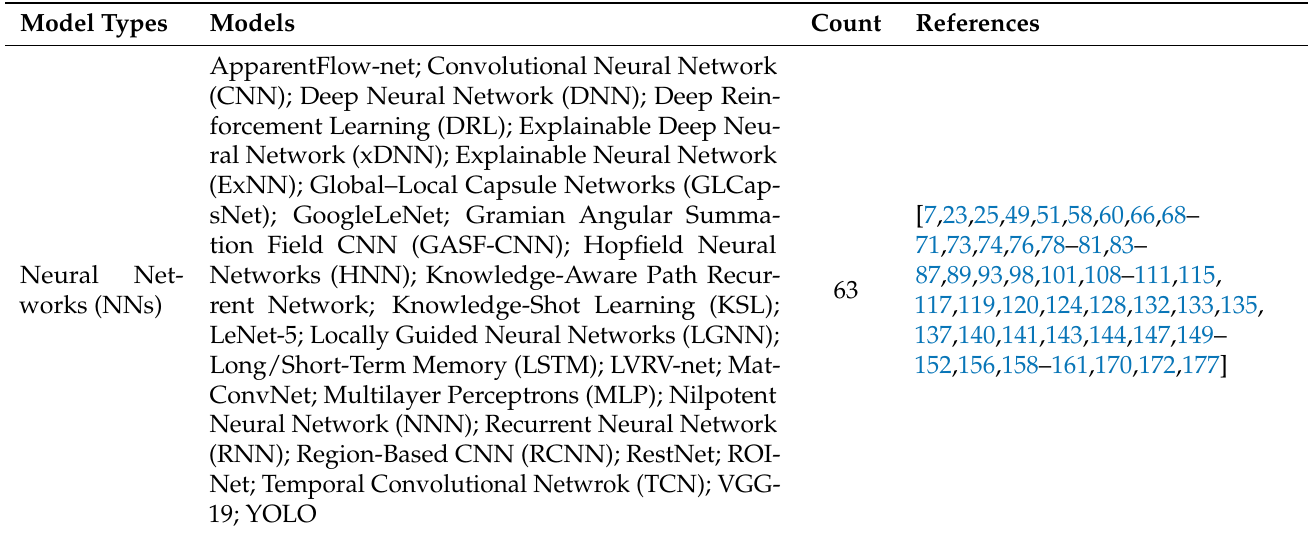
Table 5. Different models used to solve the primary task of classification or regression and their study